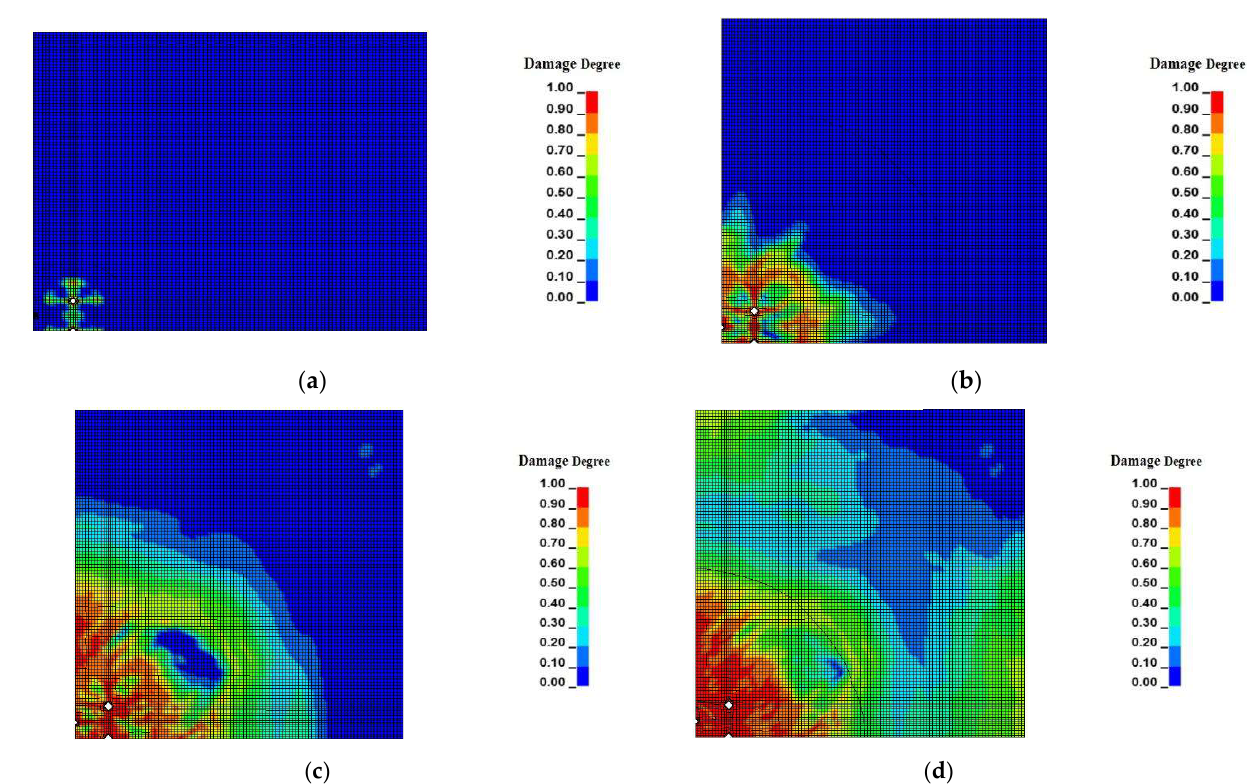
Figure 14. Blasting damage evolution law of surrounding rock at the bottom of blasting bore (Plane z = −2.0 m). ( a ) t = 0.1 ms. ( b ) t = 0.5 ms. ( c ) t = 1.5 ms. ( d ) t = 3.0 ms.